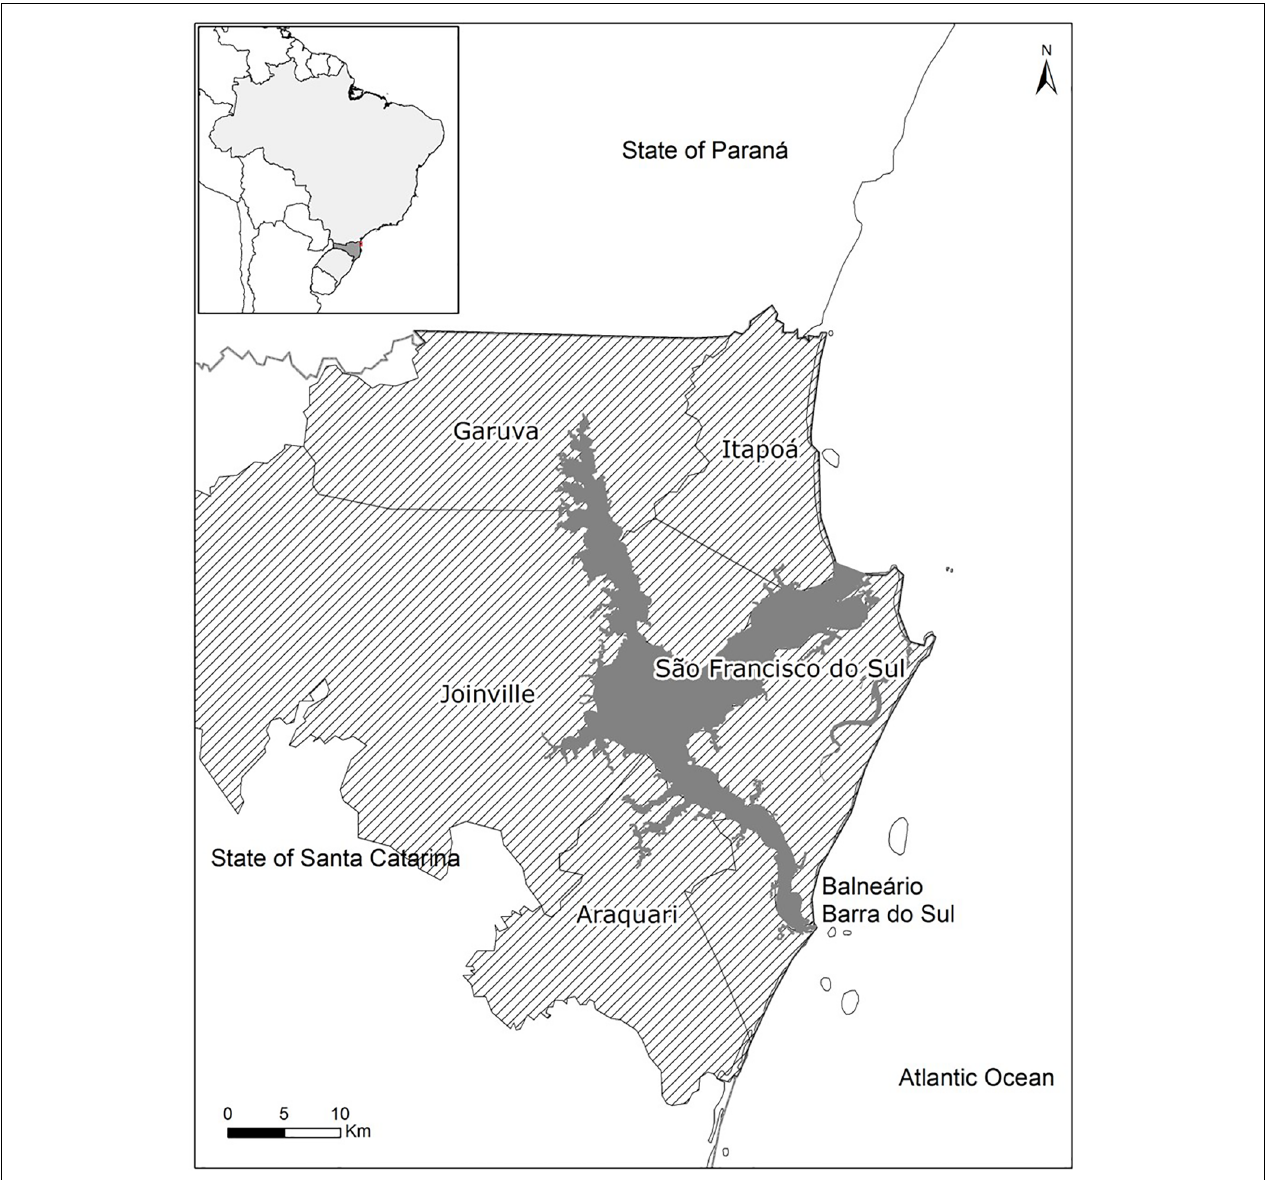
FIGURE 1 | Babitonga Bay and its six surrounding municipalities (North of Santa Catarina – Southern